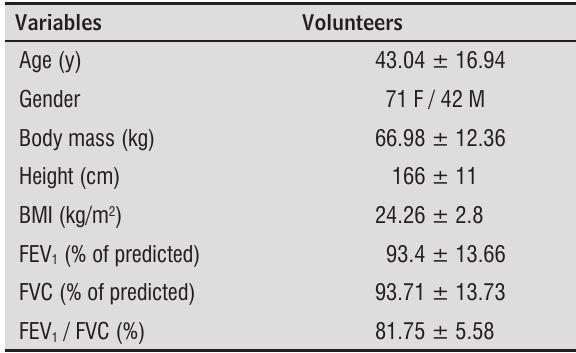
Table 1 - Demographic, anthropometric and spirometric data for 113